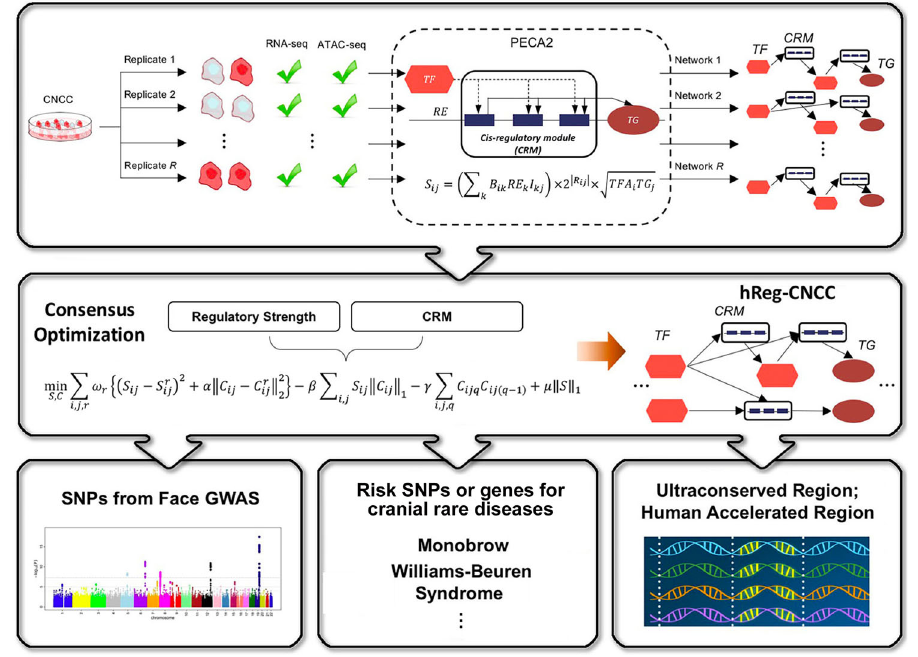
Fig. 1 Schematic overview of inferring human regulatory network of CNCC (hReg-CNCC) based on paired gene expression and chromatin accessibility data. High-quality hReg-CNCC is reconstructed by a two-step framework. Step 1: PECA2 infers context-speci fi c regulatory networks from biological replicates (see “ Methods ” for details). Speci fi cally, R CNCC replicates, each with paired RNA-seq and ATAC-seq data, are input into PECA2 and output R regulatory networks. We de fi ned the CRM associated with TF - TG pair as a set of REs bound by TF to regulate TG. Each network is denoted by TF-TG regulatory strength ( S r , r ¼ 1 ; 2 ; ¼ ; R ) and CRM ( C r , r ¼ 1 ; 2 ; ¼ ; R ), i.e., the TF-CRM-TG triplets. Step 2: Consensus optimization integrates R regulatory networks ( S r and C r ) and outputs hReg-CNCC with reliable regulatory strength S and reproducible CRMs C . hReg-CNCC serves as a valuable resource to interpret genetic variants from face GWAS, comparative genomics, and disease